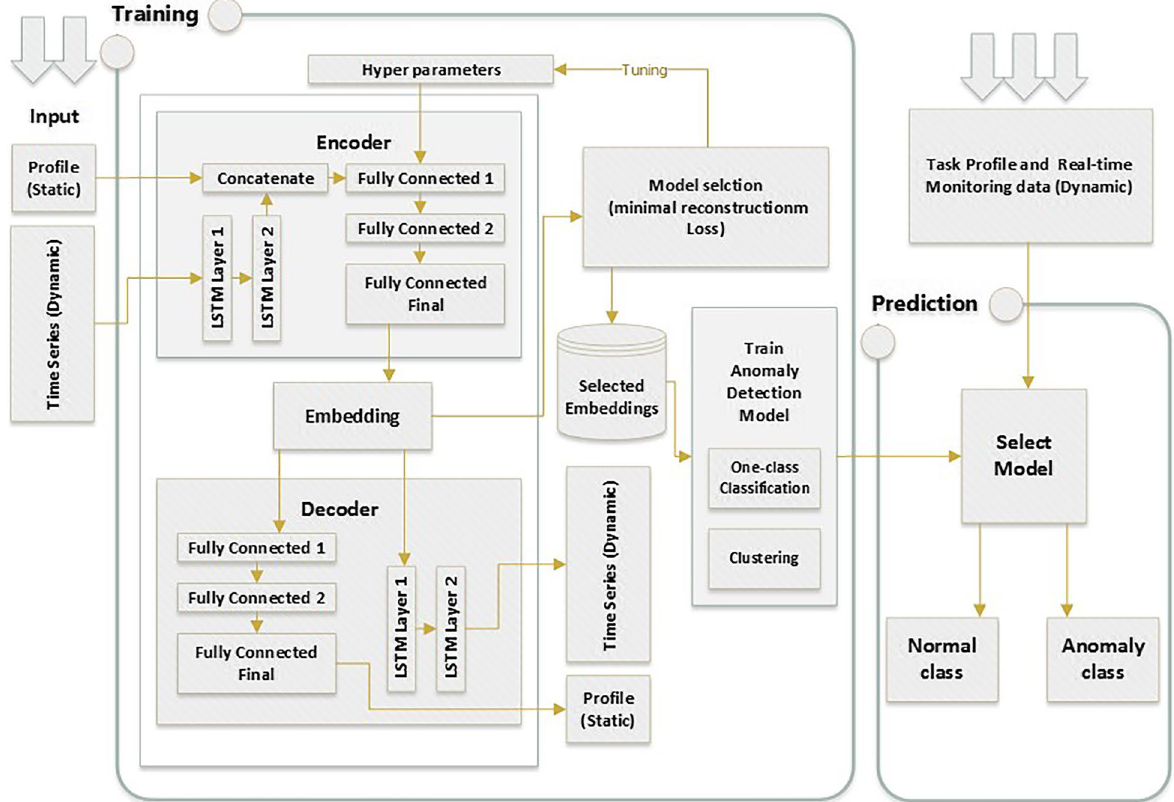
Fig. 3 High level diagram of the proposed